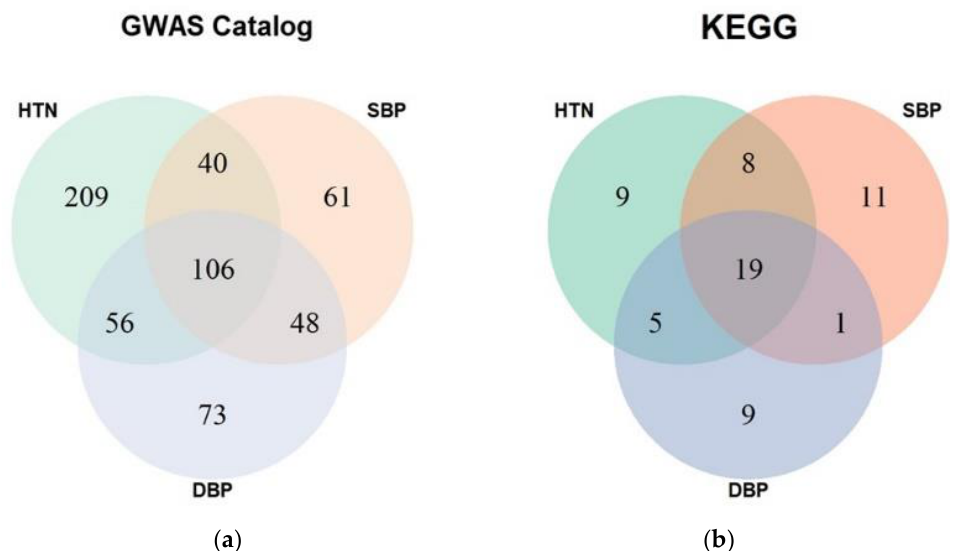
Figure 3. Venn diagrams of results from enrichment analysis with different phenotypes. The numbers indicate common